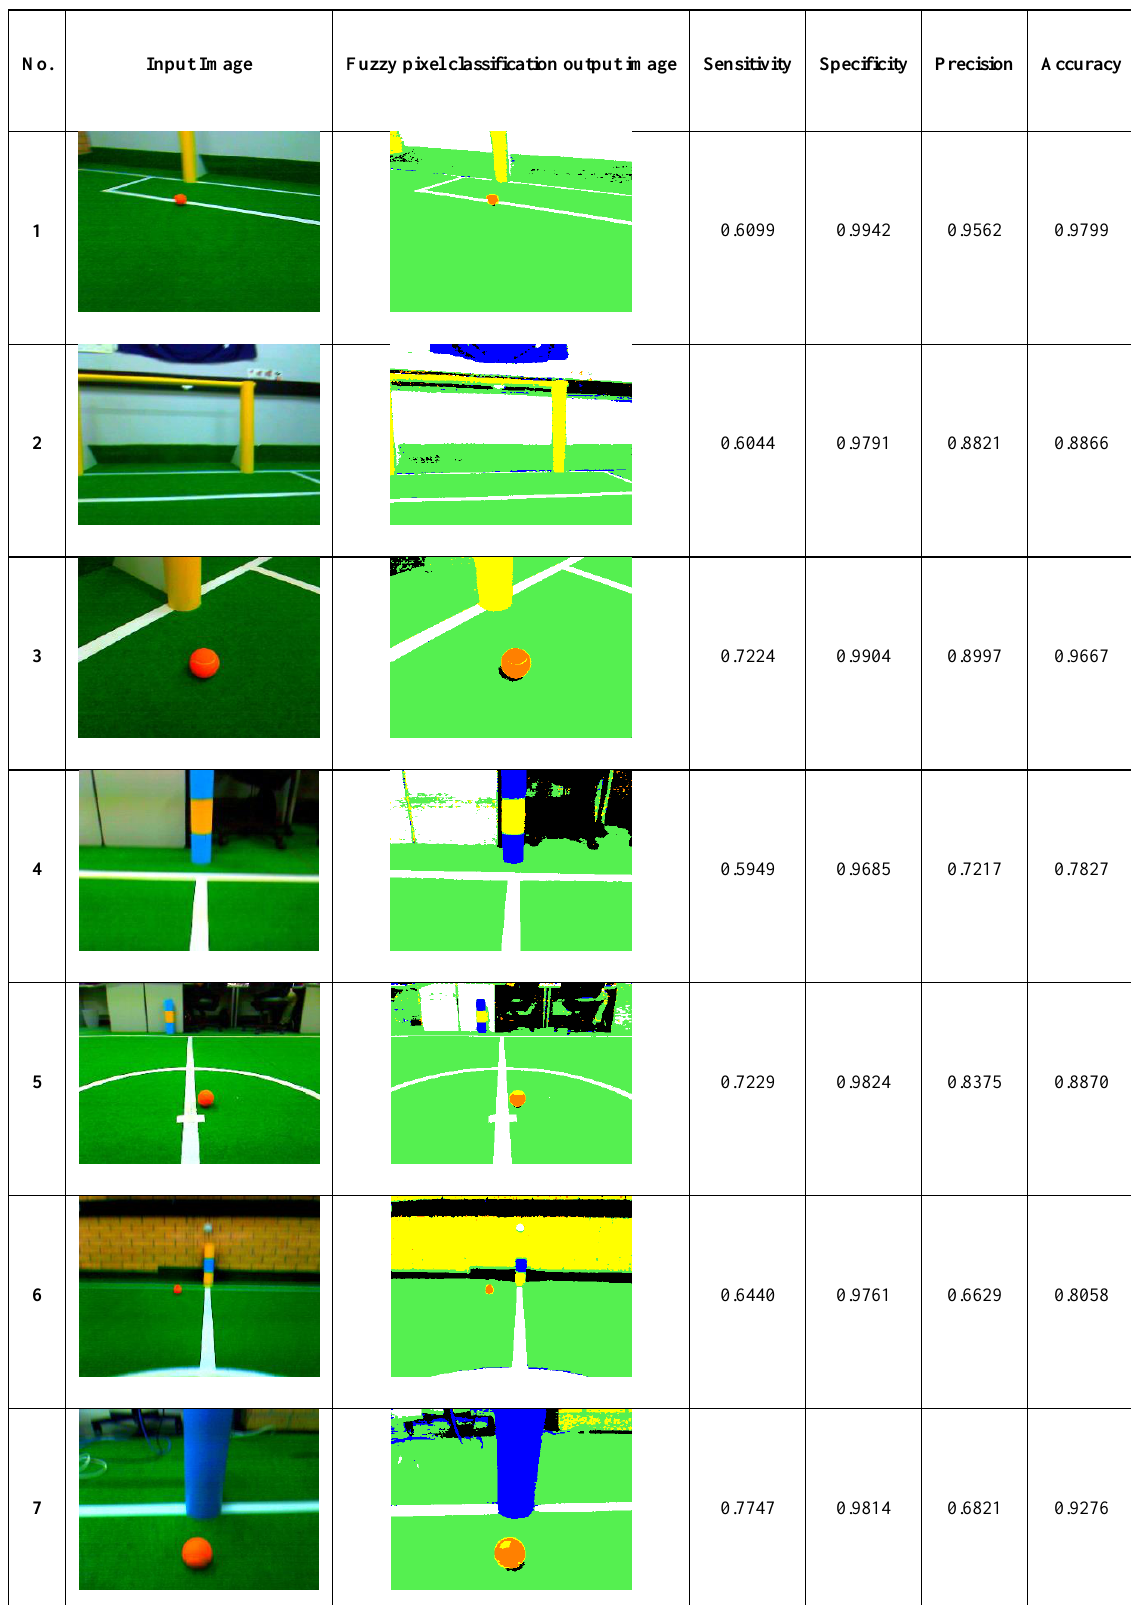
Table 3. Result of fuzzy pixel classification tuned by proposed modified CLPSO